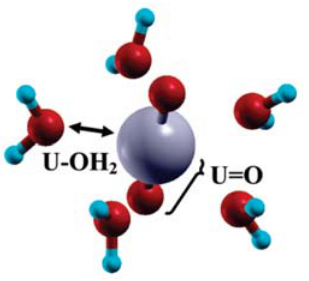
Figure 16. Optimized structure of the pentahydrated uranyl ion, [UO atom in gray, O atoms in red, and hydrogen ones in blue